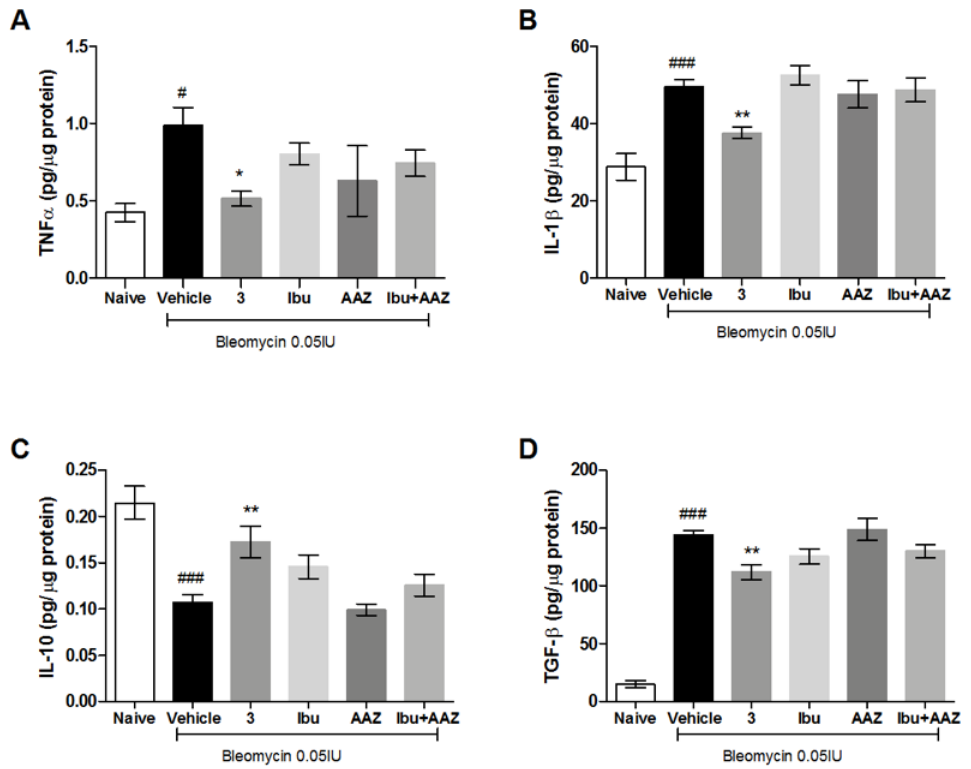
Figure 7. Determination of pro-inflammatory (Interleukin-1 β (IL-1 β ) and Tumor Necrosis Factor- α (TNF α )), anti-inflammatory (IL-10) and pro-fibrotic (Transforming Growth Factor- β (TGF- β )) cytokines. Analysis of ( A ) IL-1 β , ( B ) TNF α , ( C ) IL-10 and ( D ) TGF- β content in the supernatant of lung tissue homogenates. Values represent the mean ± SEM of six individual mice from each group performed in duplicate and expressed as pg / µ g of total proteins determined over an albumin standard curve. # p < 0.05 and ## p < 0.005 vs. Naive; ### p < 0.001 vs. Naive; * p < 0.05 vs. Vehicle; ** p < 0.005 vs. Vehicle.